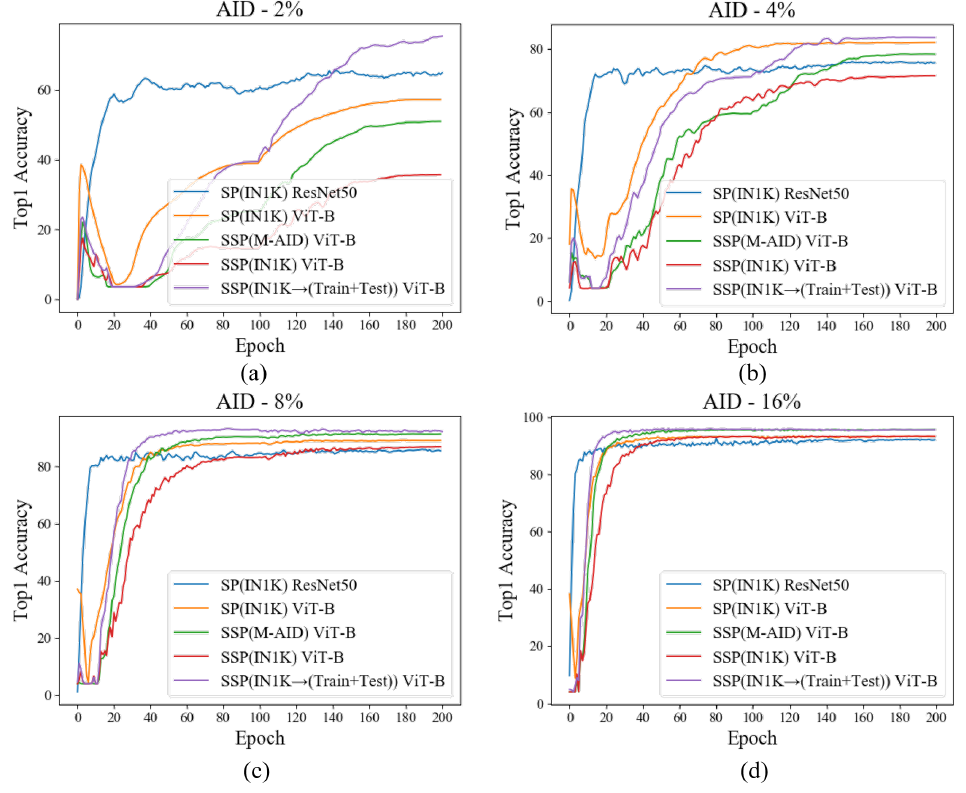
Figure 7. The Top 1 accuracy curves of fine-tuning on training data of AID [19] with different traning set ratios. ( a ) represents the Top 1 accuracy curves under the training set ratio of 2%; ( b ) represents the Top 1 accuracy curves under the training set ratio of 4%; ( c ) represents the Top 1 accuracy curves under the training set ratio of 8%; ( d ) represents the Top 1 accuracy curves under the training set ratio of